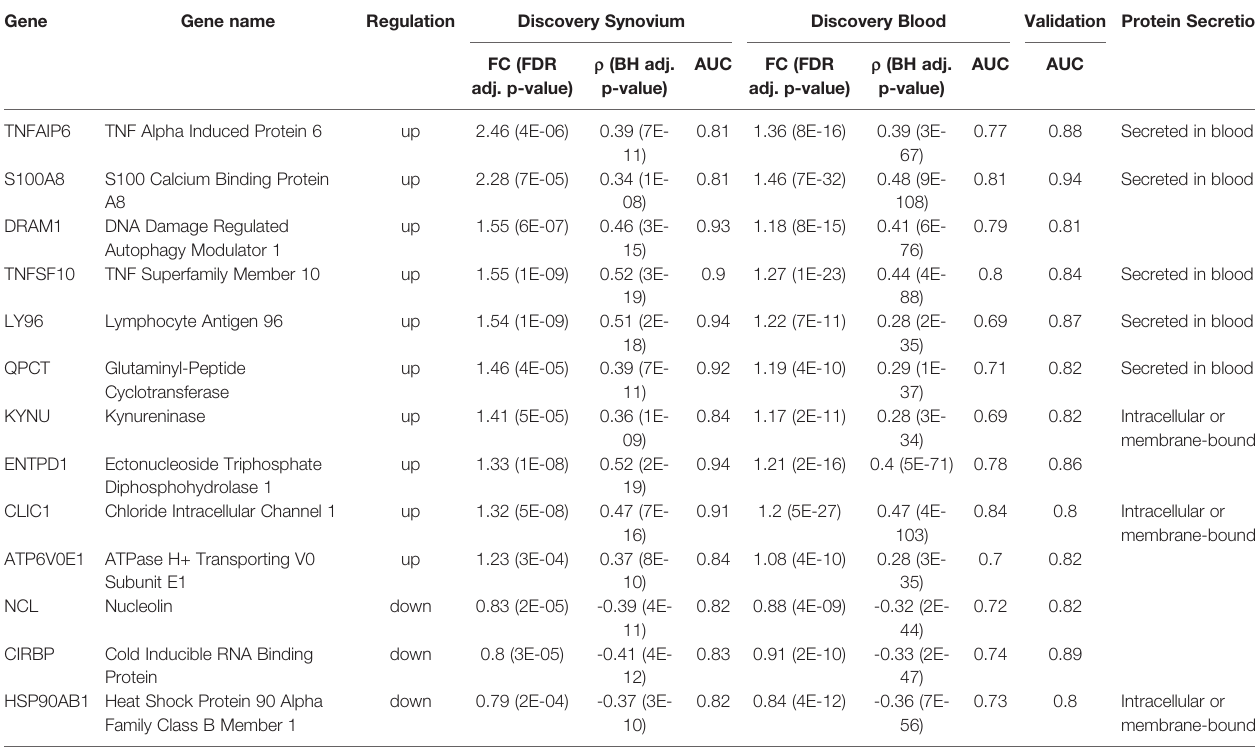
TABLE 1 | Summary of 13 validated RA Score Panel